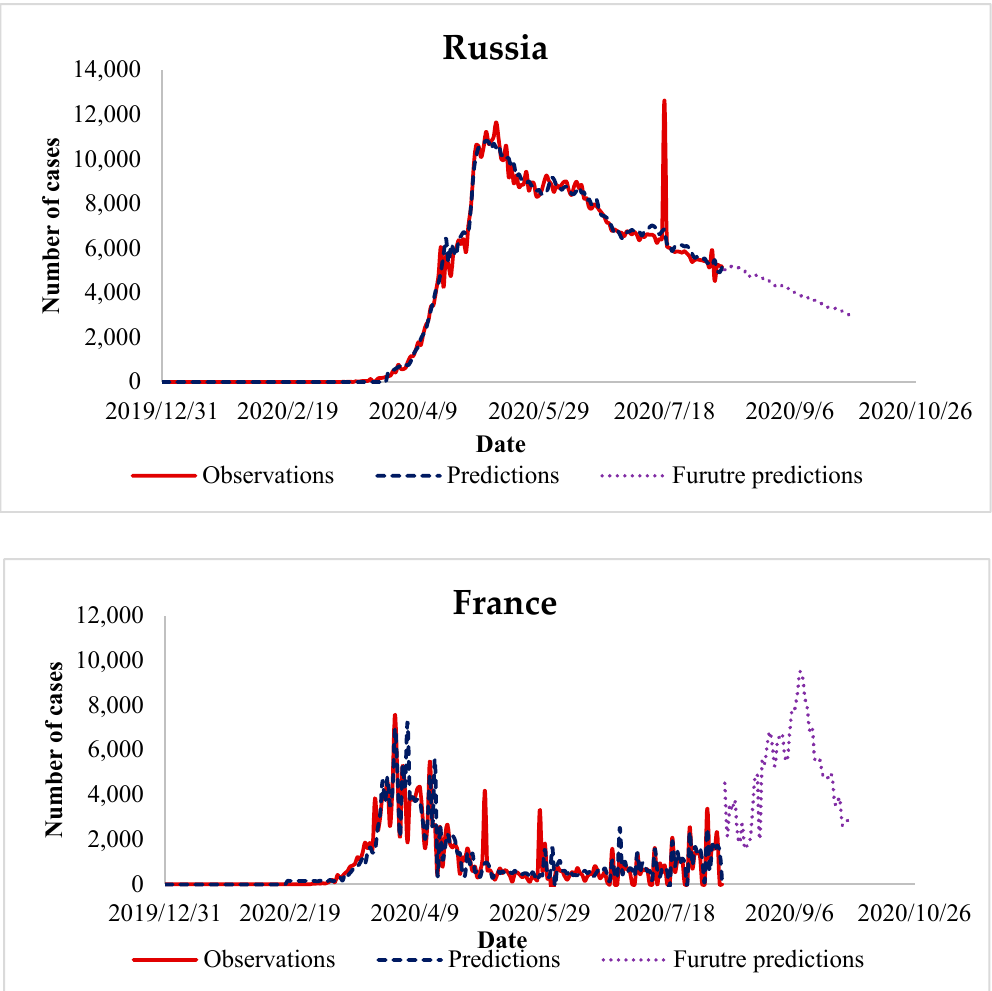
Figure 5. Future prediction of COVID-19 cases in European countries.